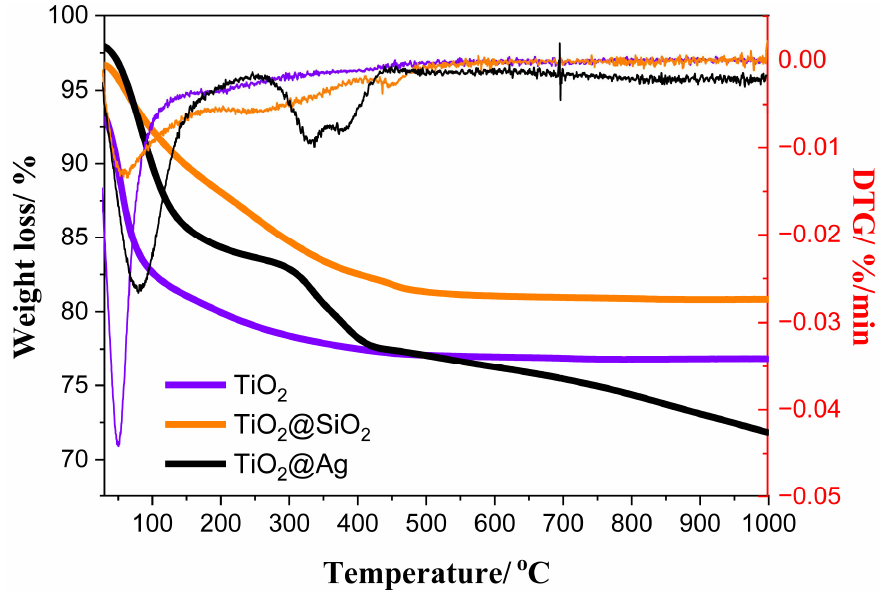
Figure 7. TG (thick lines) and DTG (thin lines) curves for TiO 2 NPs, TiO 2 /SiO 2, and TiO 2 /Ag.